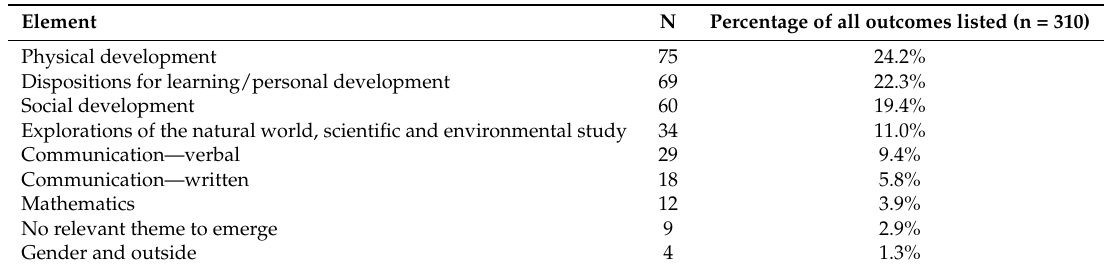
Table 2. English sample. Elements arising from analysis of ‘learning outcomes’ question and associated % of coded responses.